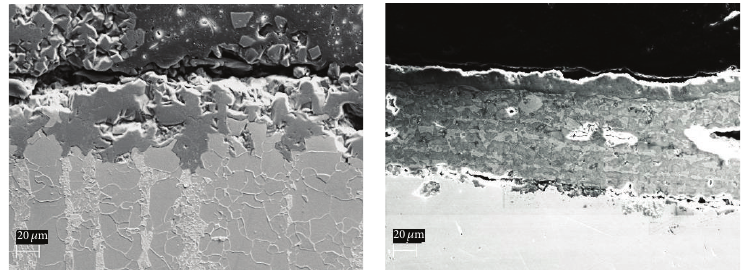
Figure 4: Image of the scale on surfaces of specimen A with different ferrite-pearlite bands orientation.